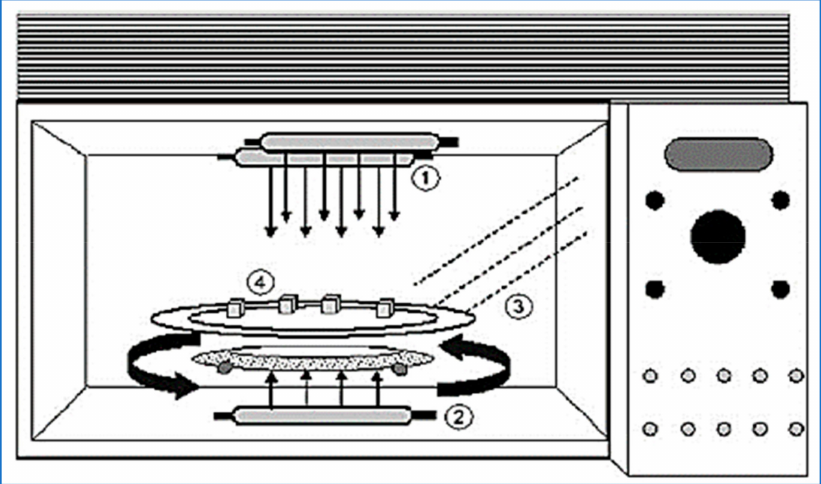
Figure 10. IR-microwave combination oven. ( 1 ) Upper halogen lamps, ( 2 ) lower halogen lamp, ( 3 ) microwaves, ( 4 ) turntable